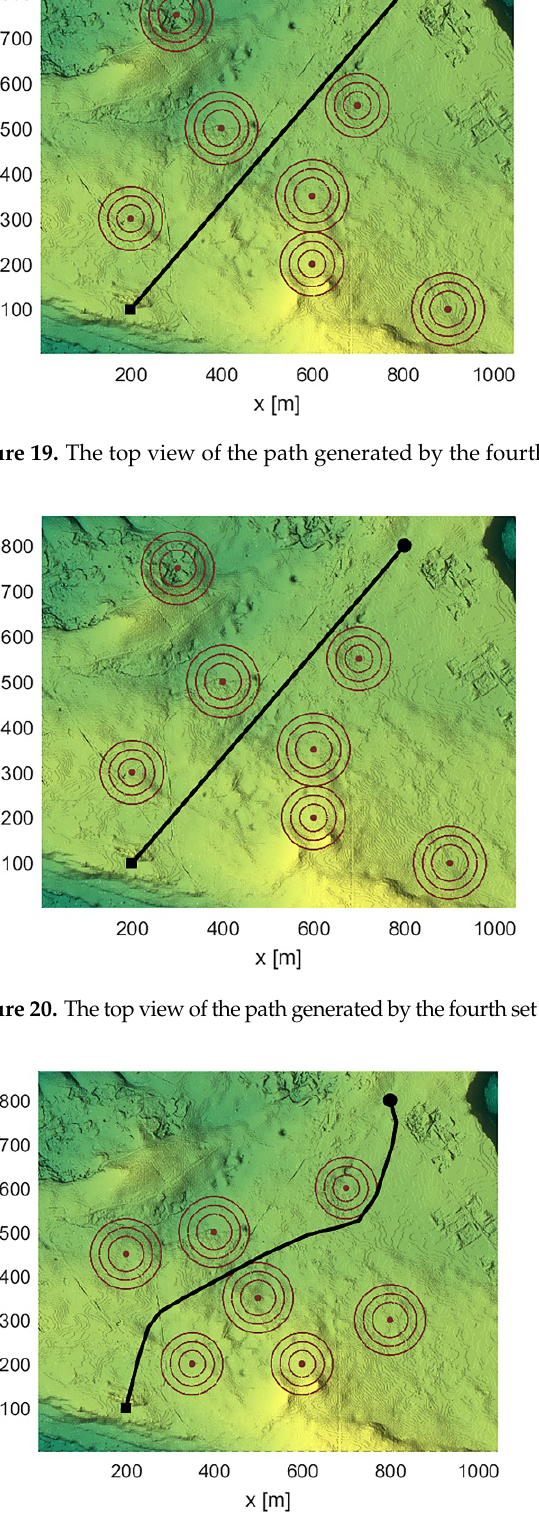
Figure 21. The top view of the path generated by the ninth group of data for the PSO algorithm.